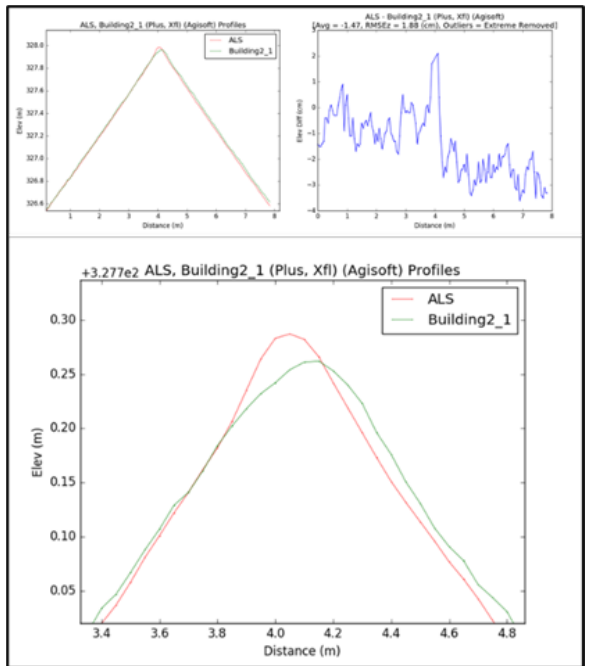
Figure 5. Sample graphical display of vertical discrepancy due to resolution of roof peak feature along building 2 (see Figure 3) The graph of differences (top right graph of Figure 5) showed that the errors of greatest magnitude occurred at the peak and errors changed direction beyond that. In the larger scale profile graph (bottom) To the right of the peak a vertical separation occurred along the remainder of the roof side.